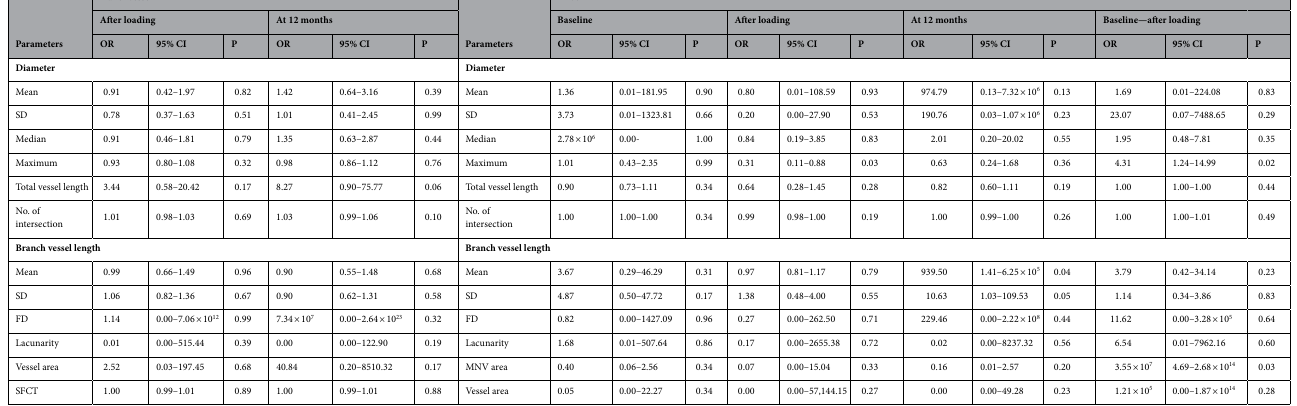
Table 2. Univariate logistic regression analysis of visual acuity gain group based on Haller vessel and MNV parameters. Age, sex, and baseline visual acuity were adjusted. Unit of vessel area, mm 2 ; unit of total vessel length, mm; unit of diameter and branch vessel length, 10 μm. MNV, macular neovascularization; Baseline— after loading, baseline value of parameter subtracted by the value after loading doses; No., number; SD, standard deviation; FD, fractal dimension, SFCT, subfoveal choroidal thickness; OR, odds ratio; CI, confidence interval.